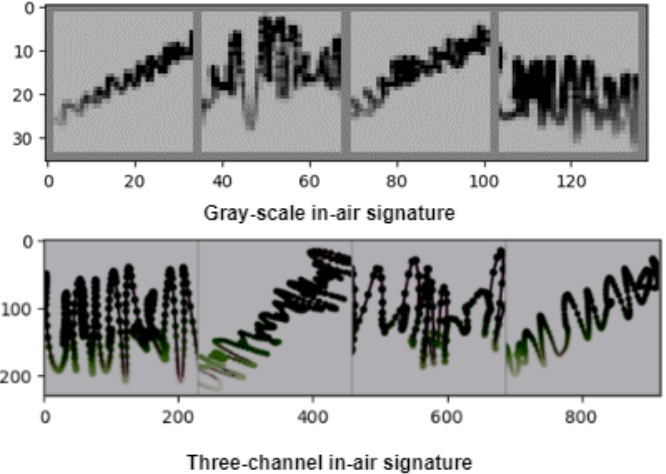
Figure 6. Gray-scale in-air signature of a 32 by 32 transformation and the three-channel RGB in-air signature of a 224 by 224 transformation.